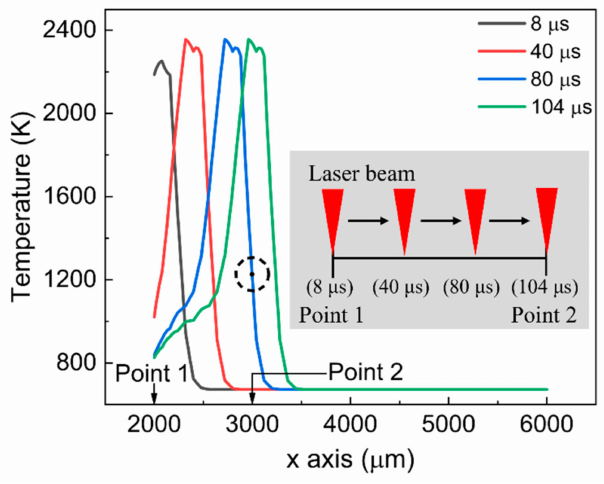
Figure 4. Spatial temperature distribution at different